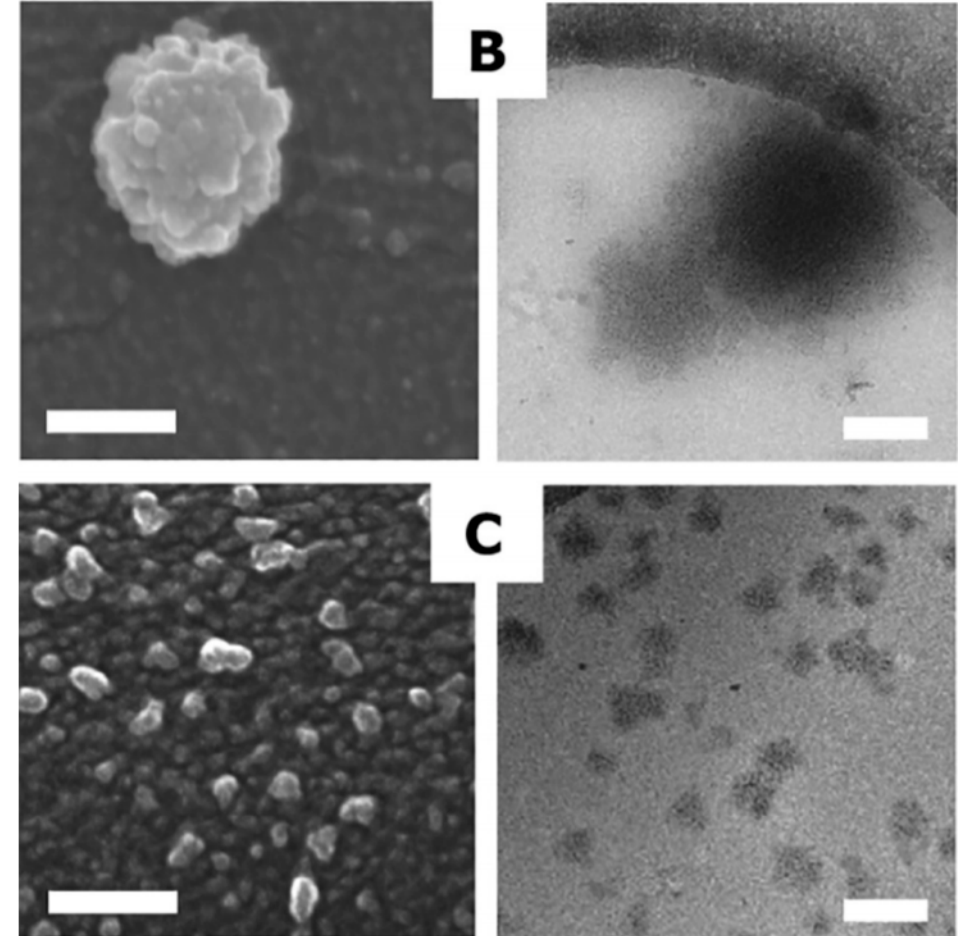
Figure 3. SEM ( left ) and cryo-transmission electron microscopy ( right ) micrographs of reformed casein micelles, untreated ( A ), sonicated for 30 min ( B ) and after a HPP of 500 MPa for 10 min ( C ). Scale: 100 nm [48]. Reproduced with permission from Yacine Hemar, Cheng Xu, Sinong Wu, Muthupandian Ashokkumar, Size reduction of “reformed casein micelles” by high-power ultrasound and high hydrostatic pressure; published by Elsevier, 2020.